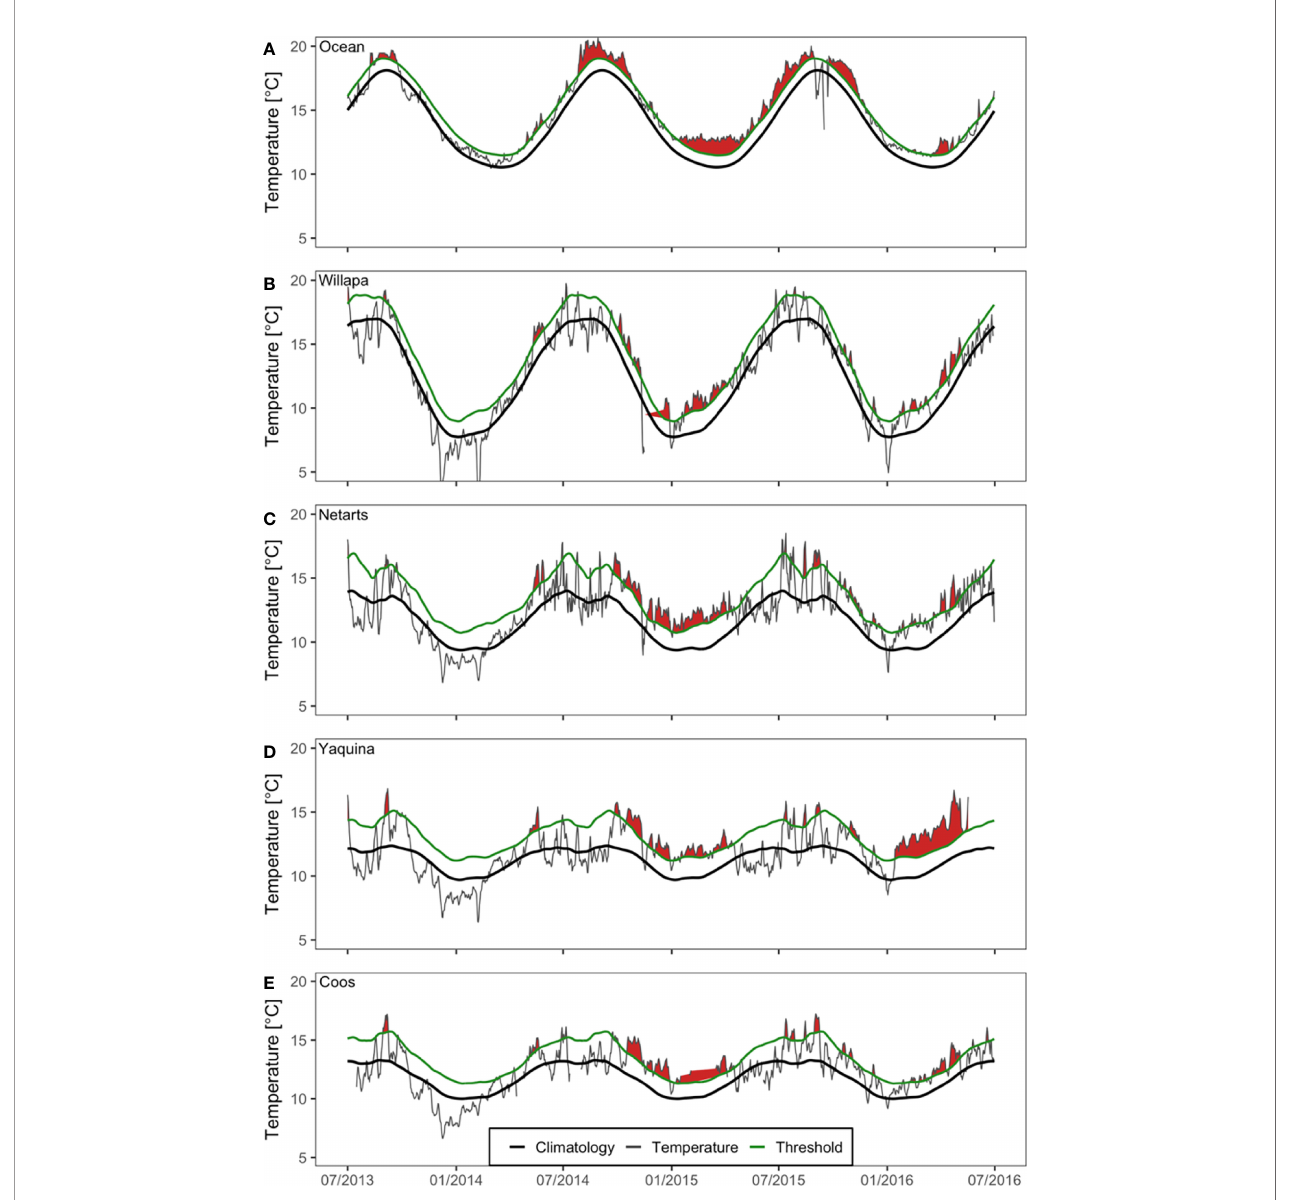
FIGURE 2 | Water temperature (gray) and detected heatwave events (red fi ll) at monitoring stations in the northeast Paci fi c Ocean (A) and four US Paci fi c Northwest estuaries ( Figure 1 ): Willapa Bay (B) , Netarts Bay (C) , Yaquina Bay (D) , and Coos Bay (E) during July 2013 – July 2016. Seasonal climatologies (black) and heatwave thresholds (green) are based on the available historical data from each estuary. Graphs were produced using de fi nitions and functions contained in the ‘ heatwaveR ’ R package (Schlegel and Smit, 2018). Occasional data gaps exist during this time period, indicated by the absence of the gray line, and heatwave condition is interpolated across missing